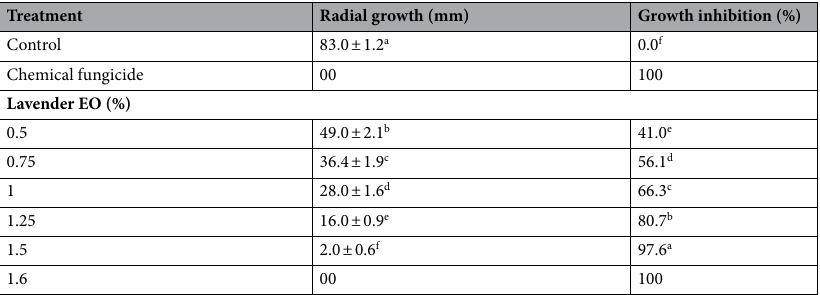
Table 1. Growth inhibition (%) of Fusarium solani when exposed to lavender essential oil at different concentrations. Values followed by the same letter are not significantly different according to Duncan’s multiple range test ( P ≤ 0.05), each value represents the mean of 3 replicates ± SD. Chemical fungicide = nystatin at 50